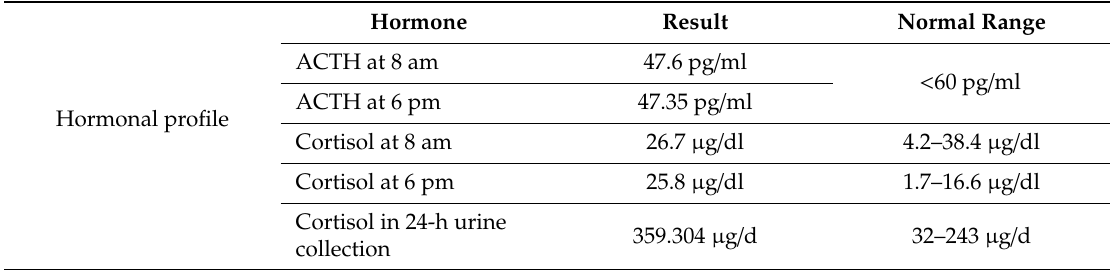
Table 3. Concentrations of chosen hormones in the described patient in 2010.